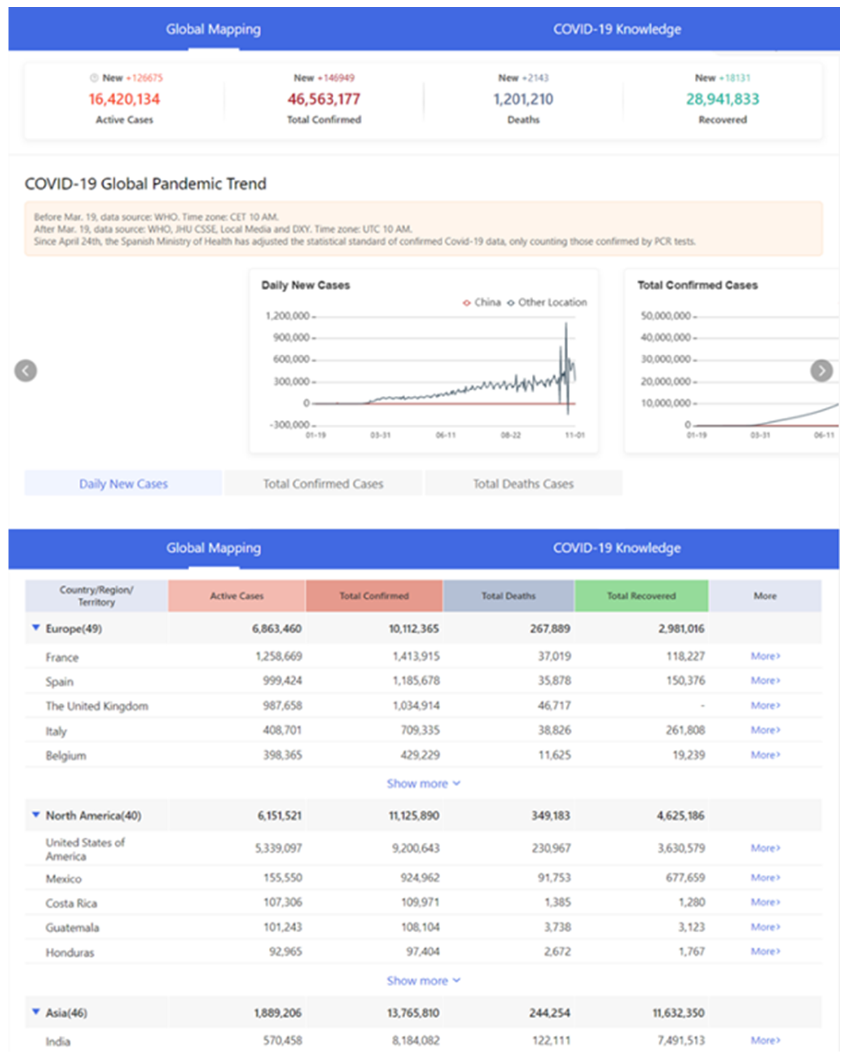
Figure 17. An example of real time report of COVID-19 in China. [230].